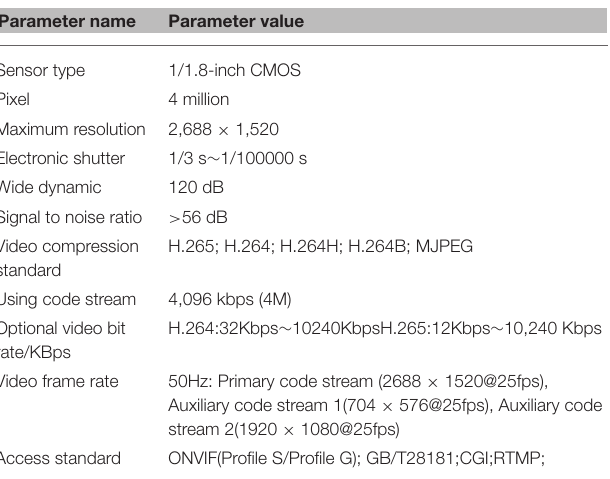
TABLE 1 | Technical parameters of the selected camera.